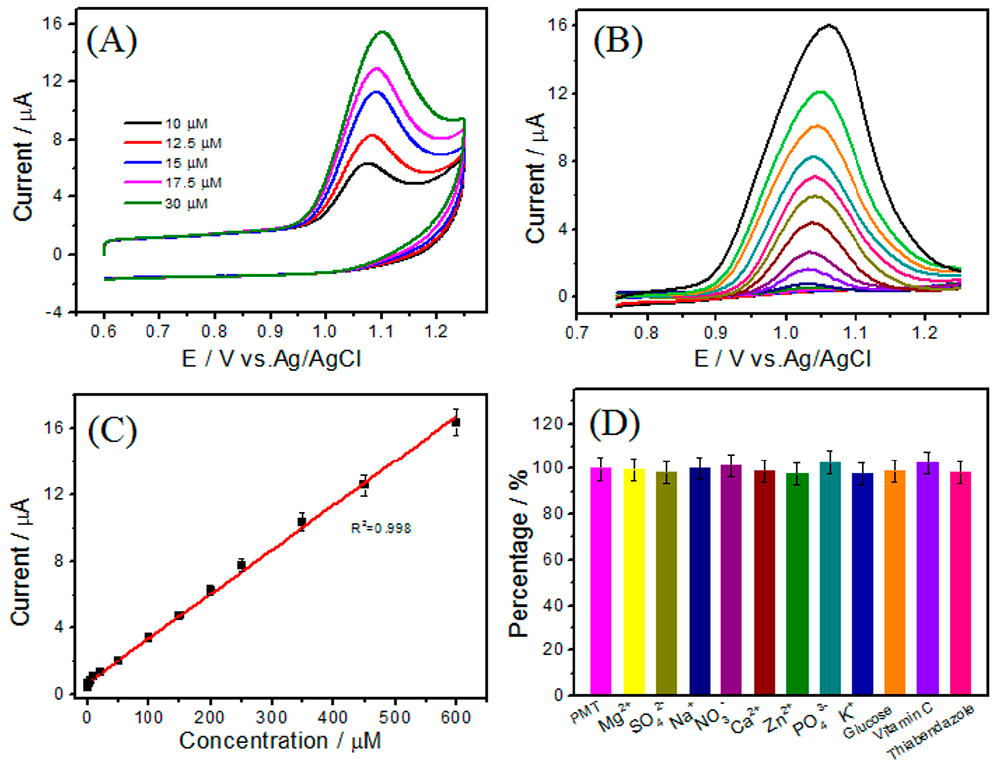
Figure 6. CVs ( A ) and DPVs ( B ) of TiC/C containing different concentrations of PMT; ( C ) is the calibration plot for PMT; ( D ) The percentage of interfering signals (NO 3 − , Mg 2+ , SO 42 − , Zn 2+ , Ca 2+ , Na + , K + , PO 43 − , glucose, vitamin C, and thiabendazole) to PMT. Table 1. Sensing performances of different methods/materials in the determination of PMT.